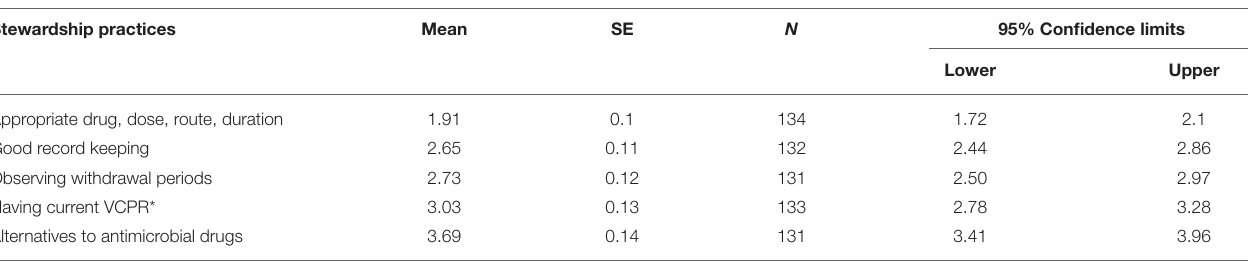
TABLE 2 | Ranking of antimicrobial stewardship practices by survey